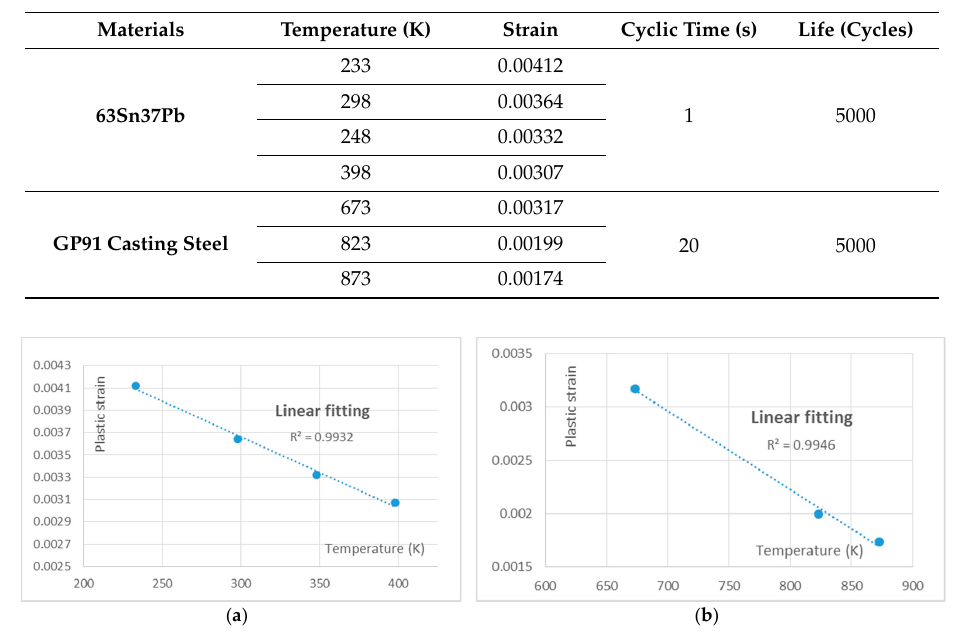
Table 1. Data of temperature-strain relation for 63Sn37Pb [21] and GP91 casting steel [30].